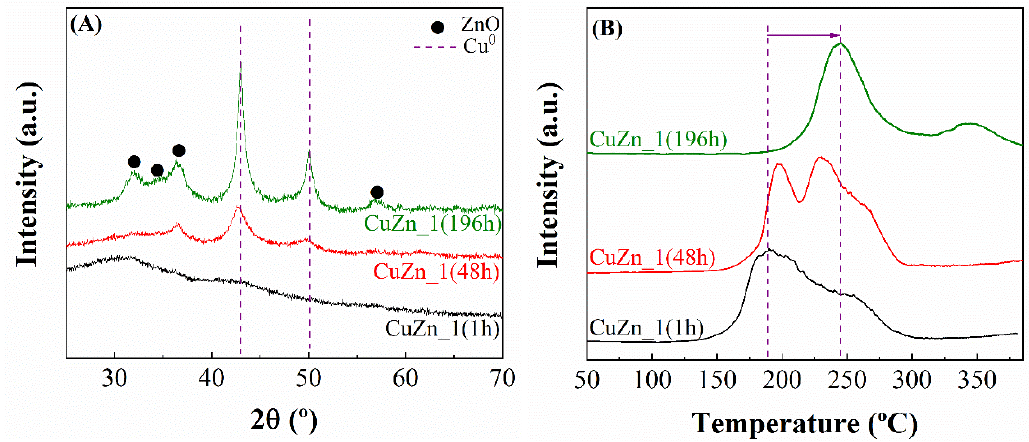
Figure 13 . Cont. Figure 13. XRD ( A ) and H 2 -TPR ( B ) profiles of CuZn_1 catalysts synthesized with different aging time.